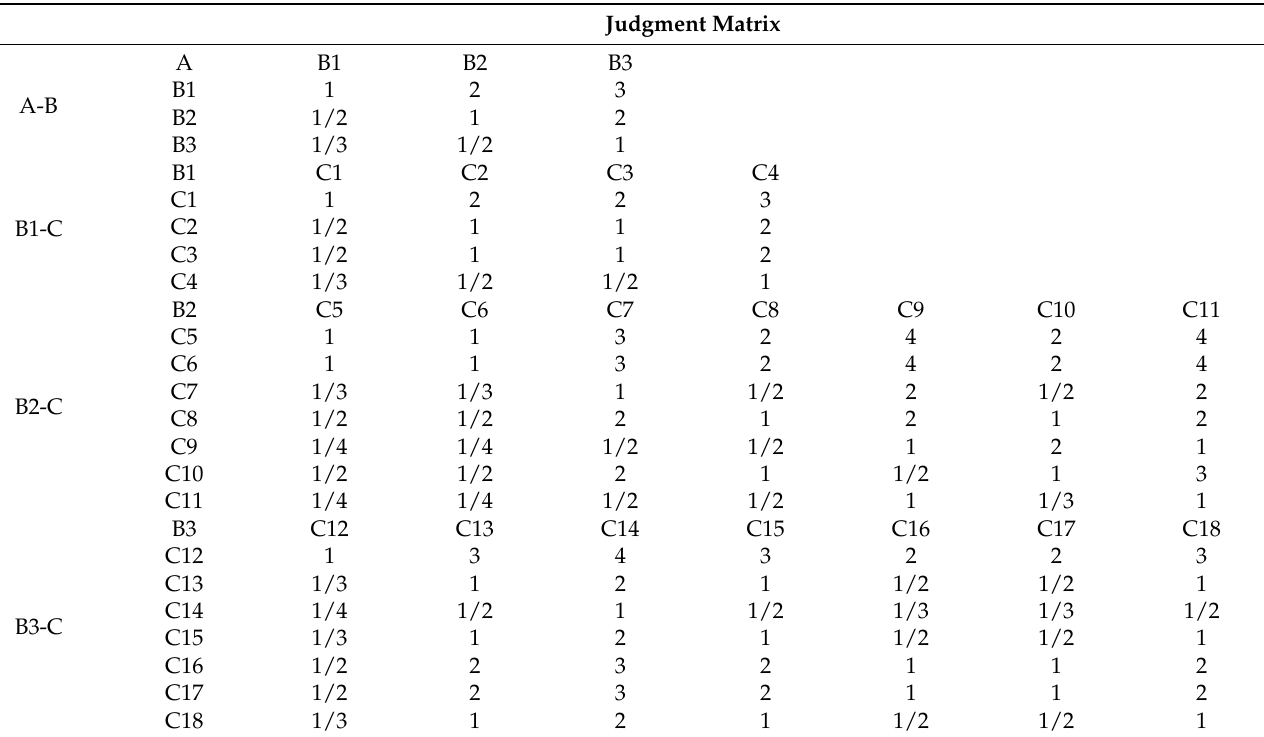
Table 7. The pairwise comparison matrix established in this study. Judgment